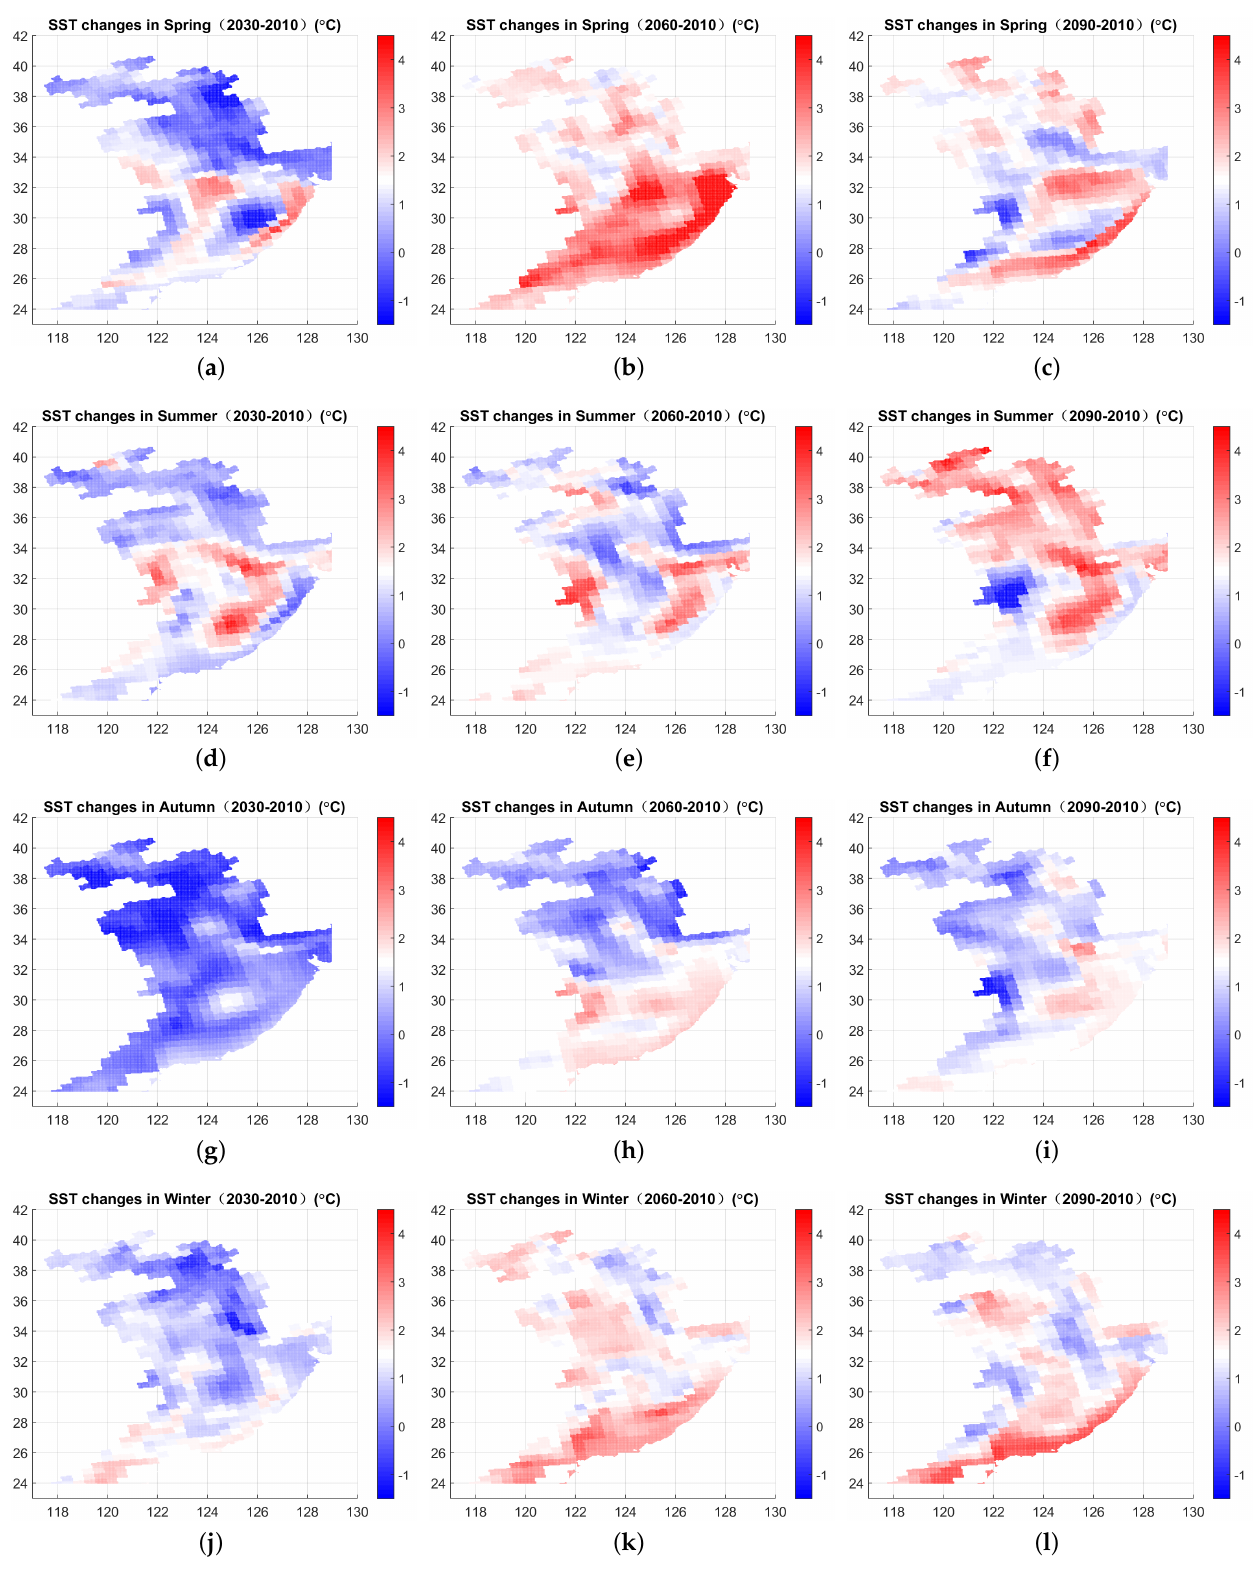
Figure 6. Seasonal changes of SST from 2010 to 2030 (the first column ( a , d , g , j )), 2060 (the second column ( b , e , h , k )), and 2090 (the third column ( c , f , i , l )), respectively. The first row to fourth row illustrates the changes in Spring, Summer, Autumn, and Winter,